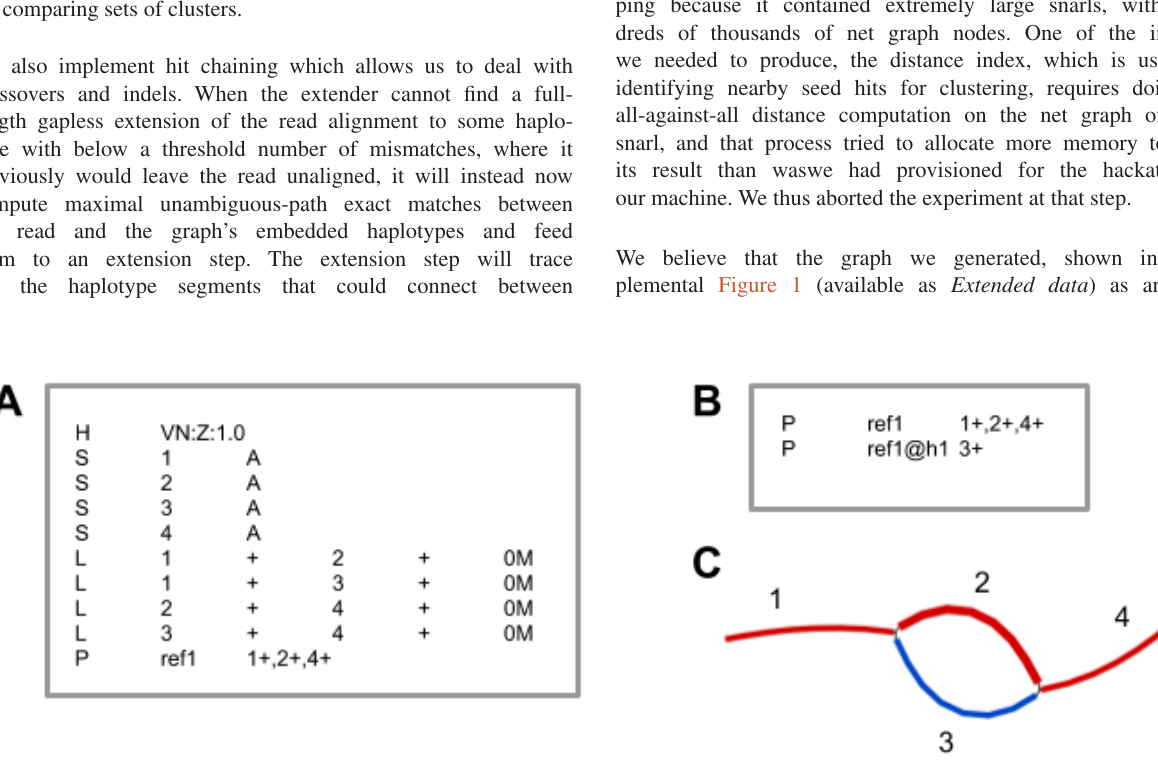
Figure 1. Proposed graph coordinate system to represent multiple haplotypes. A ) Example of a GFA file ( https://github.com/GFA- spec/GFA-spec ) that represents a reference genome and one alternate haplotype. The first line beginning in ‘H’” is the header, with an optional ‘VN’ SAM-tag version number. Nodes, represented by lines starting with ‘S’, have a name in the second column and a nucleotide sequence in the third column. Edges, represented by lines starting with ‘L’, connect nodes whose sequence appears adjacent to each other in one of the haplotypes. The node names appear in the second and fourth columns, and the orientations appear in the third and fifth columns. The line beginning with ‘P’ is from GFA version 1, and encodes subgraphs and paths. B ) A path file accompanying the GFA file includes paths for the reference genome and haplotype 1. The haplotype name is in column 2 and the sequence of nodes and their orientations are in column 3. The nucleotide sequence for any haplotype can be resolved by reading out the sequence for each node in the path. C ) Visualization of A using path labels from B . The red path represents ref1, while the blue path represents haplotype